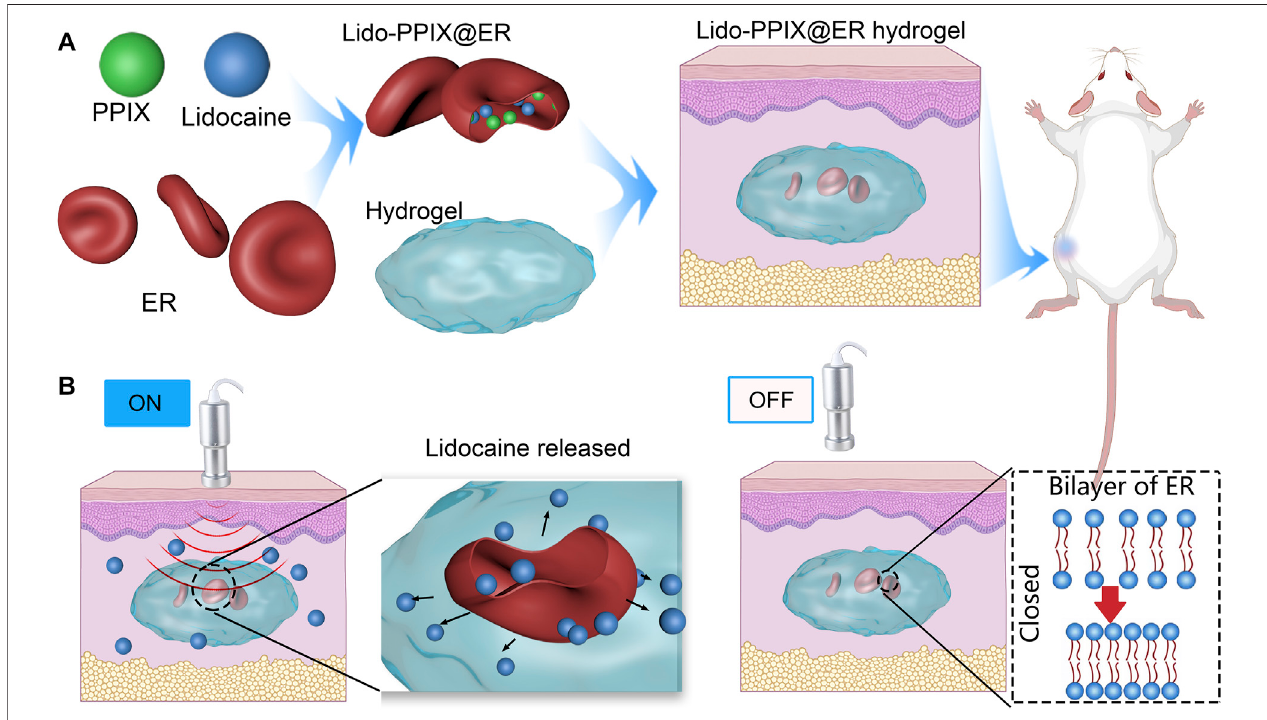
SCHEME 1 | Schematic representation of erythrocyte-inspired and ultrasound-triggered Lido on demand release platform. (A) Formation of the Lido-PPIX@ER hydrogelinwhichultrasound(0.3 W/cm 2 ,30 s)triggersthereleaseoflidocaine(Lido).ERs(erythrocytes)wereselectedasthelidocaineandPPIXcarrier.Theaminoacid hydrogel functions as a hydrogel 3D scaffold material, which offers increased subcutaneous ER stability. (B) A schematic representation showing the ultrasound- regulated Lido release from the Lido-PPIX@ER hydrogel. After surgery, following ultrasound irradiation (0.3 W/cm 2 ), PPIX improves active oxygen production, promoting pore formation on the erythrocyte membrane, and allowing lidocaine release. Turning off the ultrasound leads to closure of the pores on the ER membrane, suppressing lidocaine release. The Lido-PPIX@ER hydrogel allows on-demand lidocaine release from the subcutaneous lidocaine reservoir by remote control.